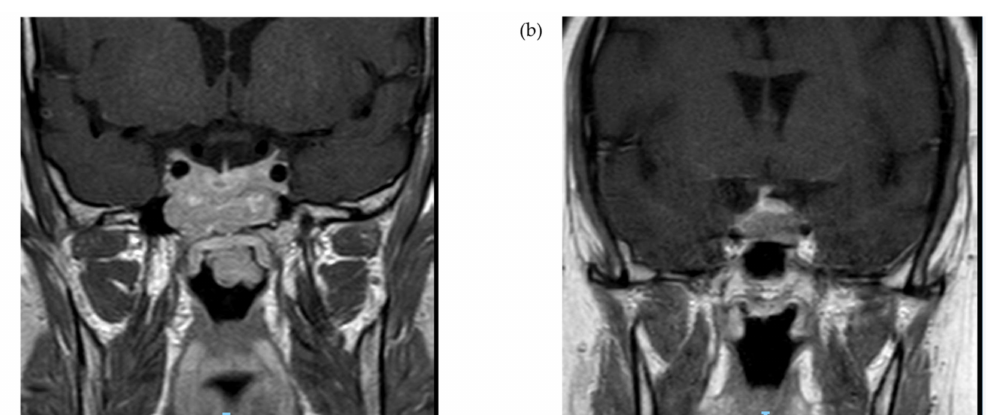
Figure 3. Illustrative radiographic MR imaging. Coronal T1, non-contrast ( a ) suprasellar and infrasellar lesion with a large exophytic portion invading into the nasopharynx, involving the clivus and the sphenoidal sinus (Patient #6); ( b ) a suprasellar lesion invading into the left cavernous sinus (Patient